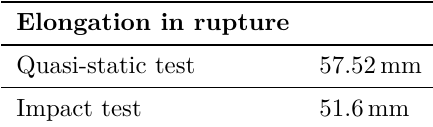
Table 2. Elongation in rupture for quasi-static and dynamic